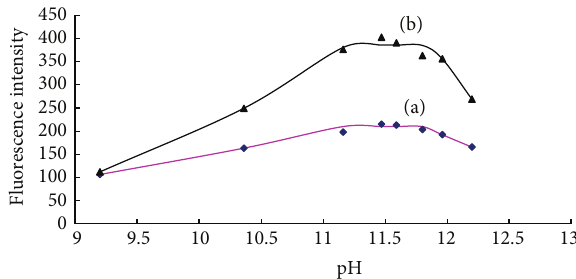
Figure 7: Effect of pH on the fluorescence intensities of blank (a) and 0.200 𝜇 mol/L ammonium working solution (b).